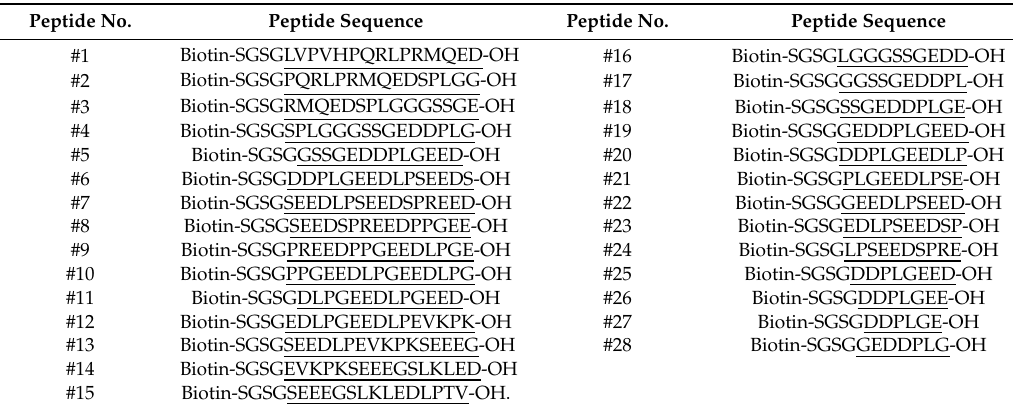
Table 1. Sequences of synthetic peptides used for epitope